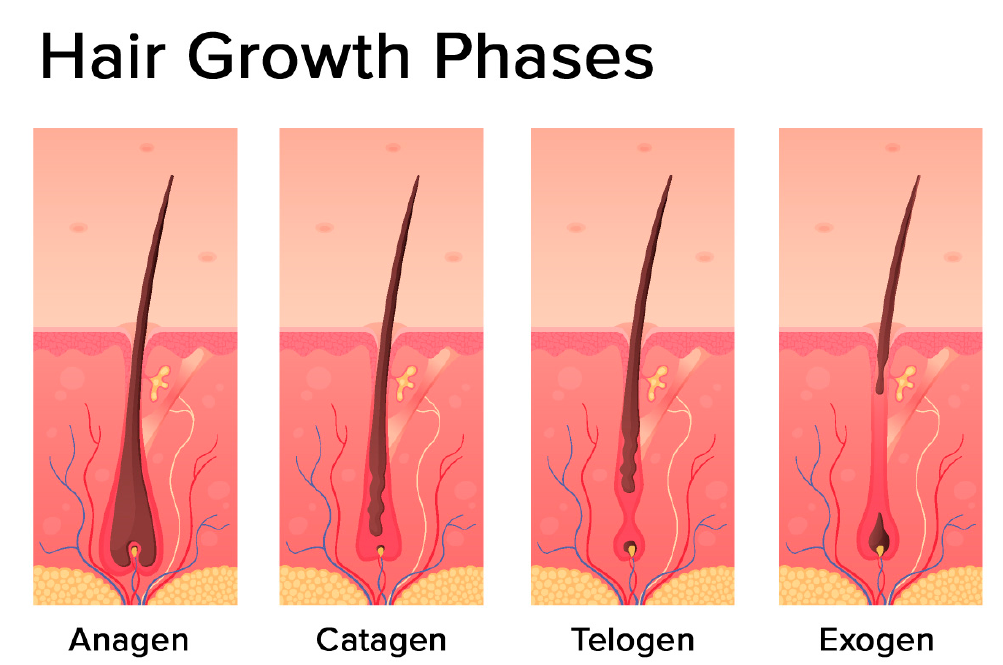
Figure 2. Hair growth phases: anagen (growing phase), catagen (transition phase), telogen (resting phase), exogen (shedding phase) (modified photo from Freepik).